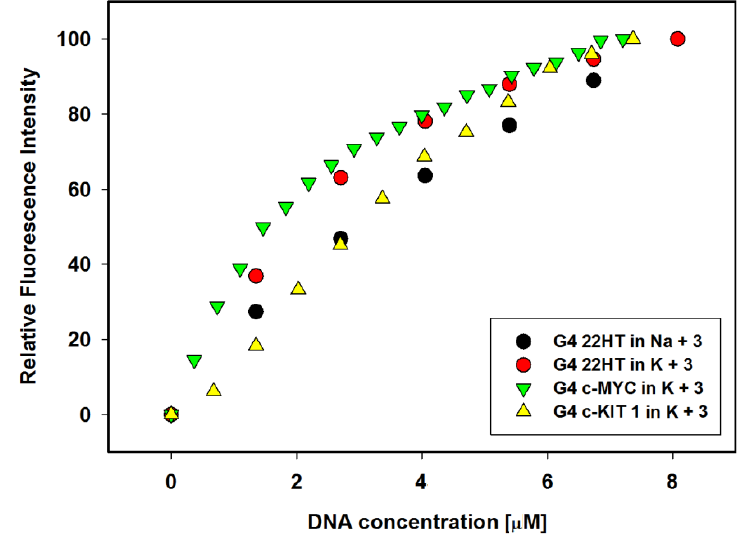
Figure 5. Comparison of the relative enhancement in the fluorescence intensities of ligand 3 vs. the increasing concentration of G-quadruplexes 22HT, c-MYC and c-KIT1.